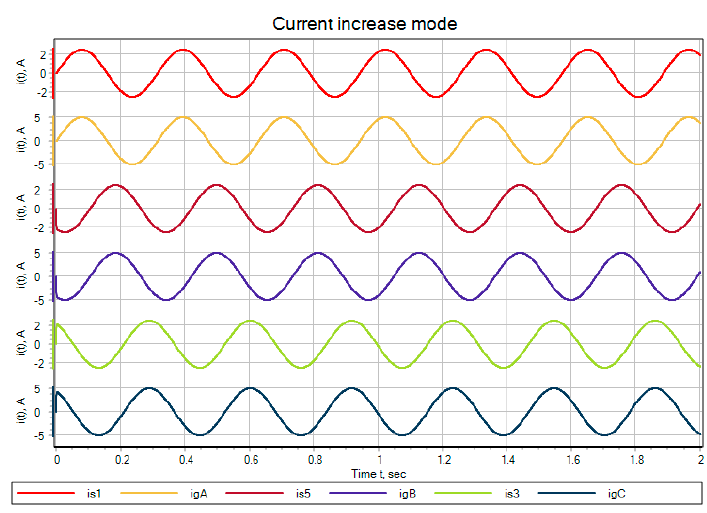
Figure 25. Voltage across the generator windings.